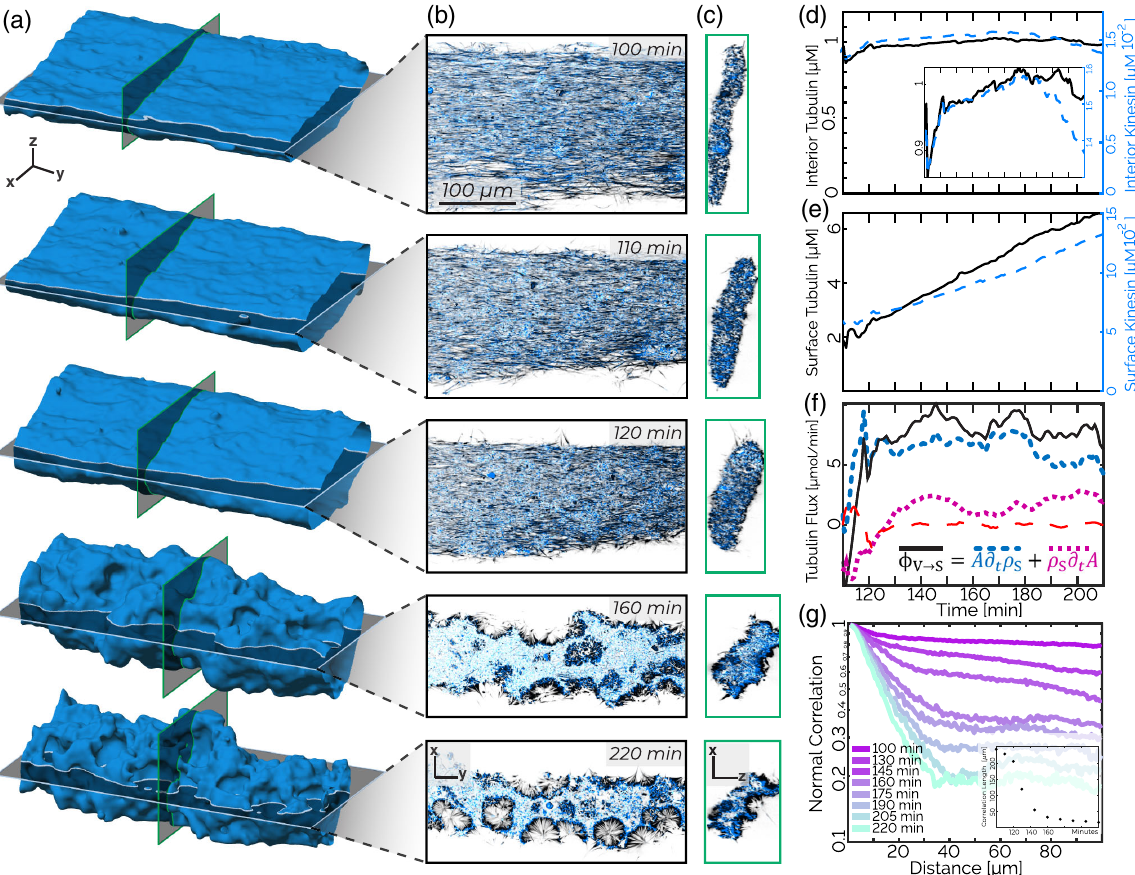
FIG. 5. Contracting gel: Surface roughening is accompanied by the formation of a surface-bound monolayer. (a) Time series of a surface of a contracting network. (b) x - y slices of data corresponding to cuts shown in the previous panel reveal the formation of a monolayer and invaginations at late times. (c) x - z slices show a contracting cross section until the roughening commences. (d) Tubulin and kinesin density within the interior of the contracting network is constant during the roughening phase. (e) Tubulin and kinesin density within 5 μ m of the surface increases during the roughening phase. (f) The flux of microtubules from the interior to the surface Φ A ∂ ρ ρ ∂ A (purple short- V → S (black solid line), the microtubule surface density t s (blue dashed line), and the change in surface area s t dashed line) as a function of time. The red long-dashed line indicates the sum of all three terms. (g) Normal-normal spatial correlations show faster decay as the material roughens. These correlations are calculated only on a bisected surface, to reduce the influence of the overall surface curvature. Inset: Exponential fits to the normal-normal correlation decay between 10 and 20 μ m show correlation length decreases by 200 μ m over 50 min. The sample consists of 10 μ M tubulin (black) and 200 nM kinesin